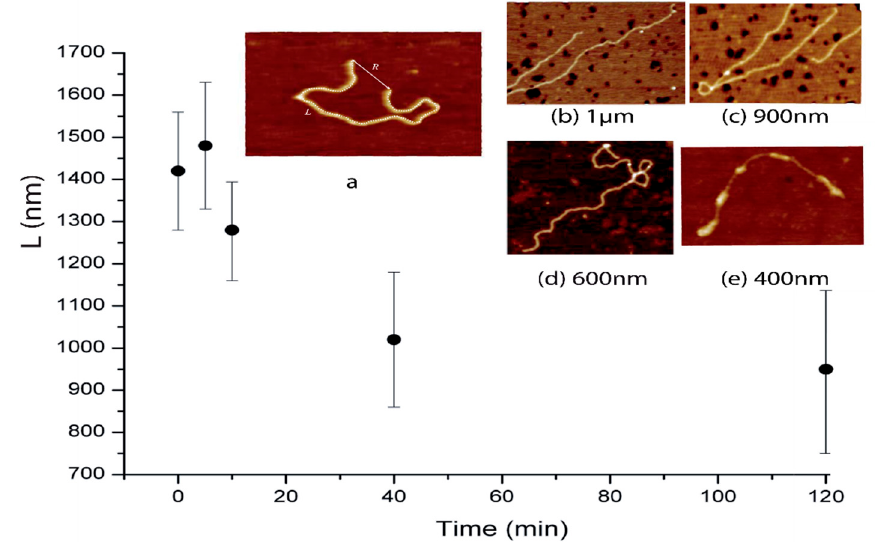
Figure 5. DNA length extracted from the atomic force microscopy (AFM) images as a function of platinum complex incubation time. The contour length L increases rapidly after 5 min before a continuous decrease. The image shows the DNA ( a ) conformations and length at ( b ) 5, ( c ) 10, ( d ) 40 min, and ( e ) 20 h. The sizes on bottom of the images represent the horizontal full scale of the images represented.